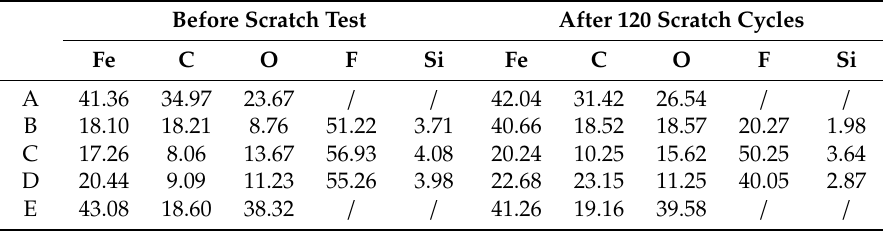
Table 3. Chemical composition of samples A–E before and after scratch test. Before Scratch Test After 120 Scratch